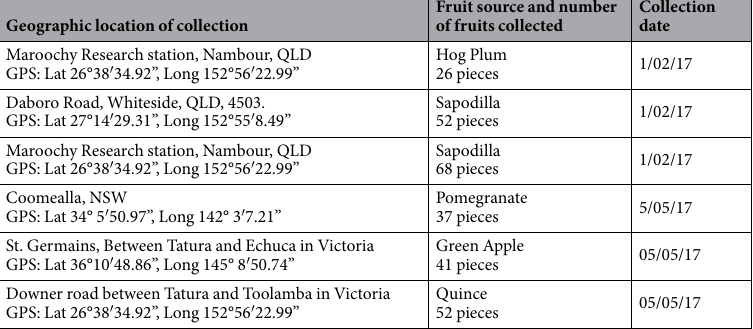
Table 3. Fruit types and origin for wild Bactrocera tryoni larvae collection. A total of six replicate larvae, and fruit flesh samples were collected from each fruit